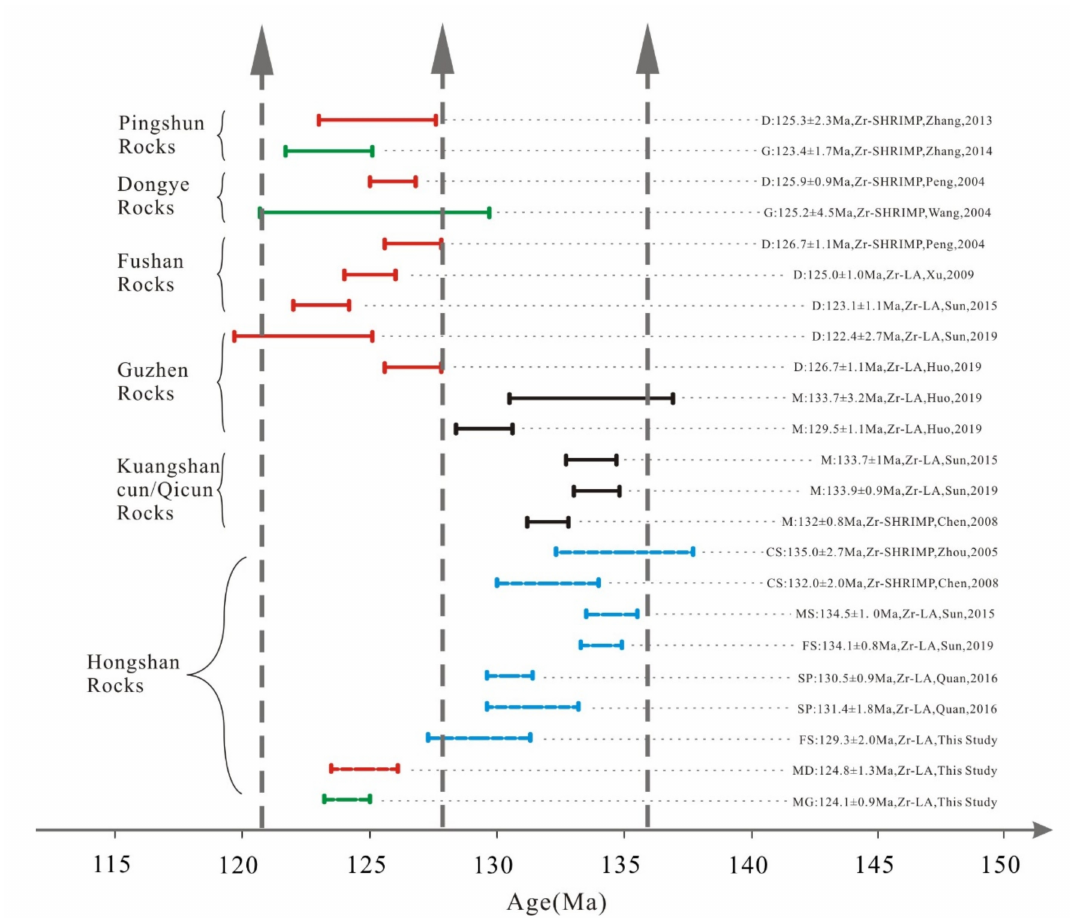
Figure 11. The ages of Mesozoic rocks from the Handan area. G: Gabbro, D: Diorite, MG: monzo-gabbro, MD: monzo-diorite, M: monzonite, CS: coarse-grained syenite, MS: medium-grained syenite, FS: